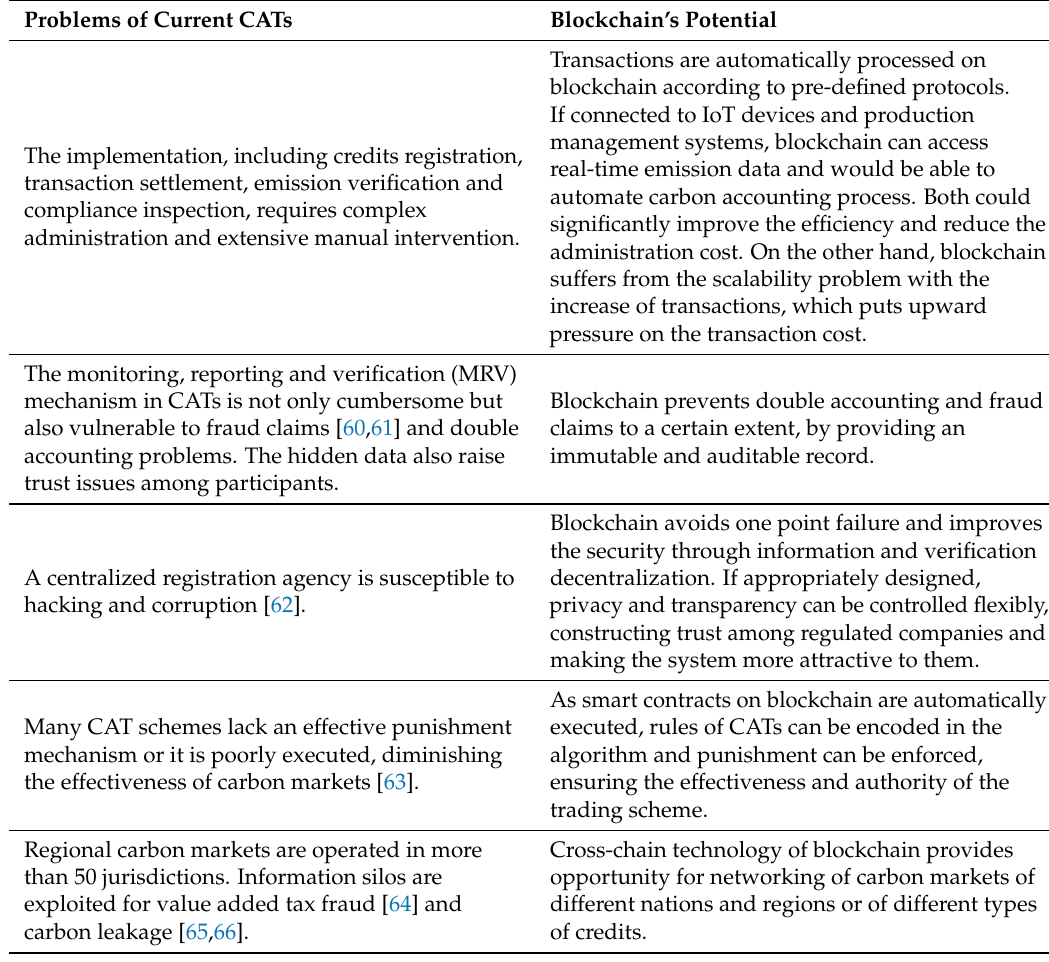
Table 1. Problems of current cap and trade schemes (CATs) and blockchain’s potential Problems of Current